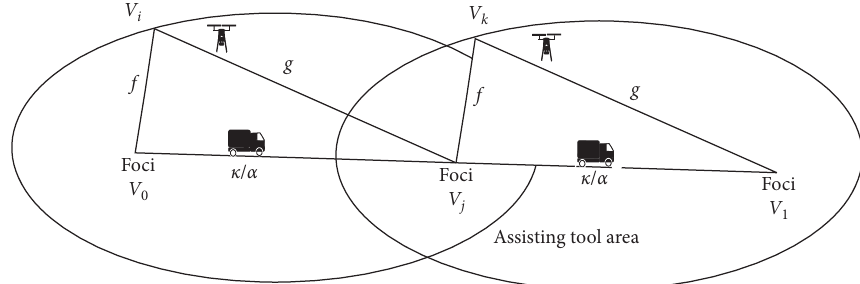
Figure 5: Best-case geometric layout for truck-multiple-drone